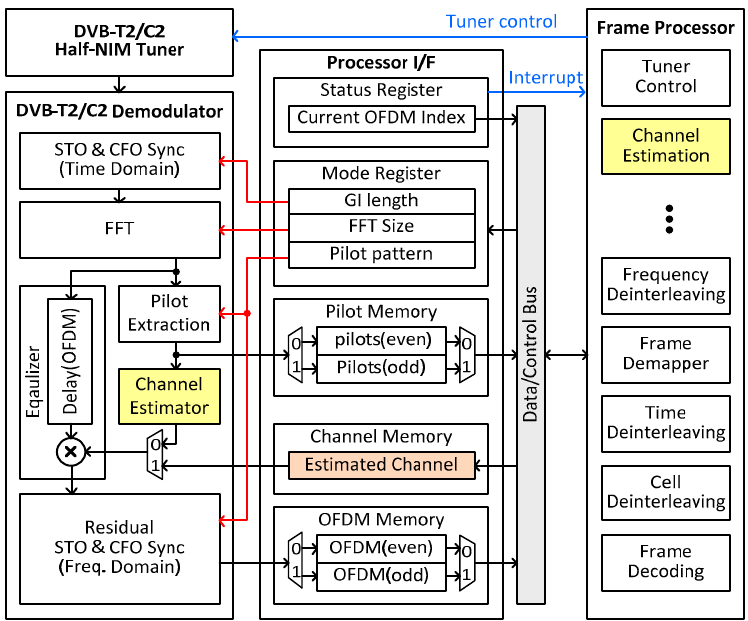
Figure 5. Block diagram of the proposed OFDM demodulator.